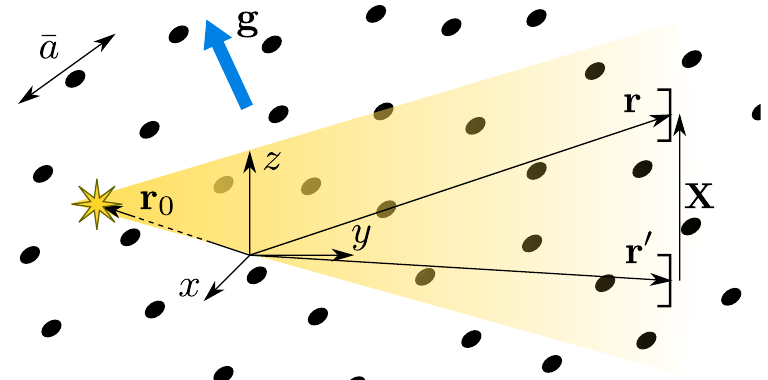
Figure 1. Schematic representation of the light propagation from a source at a point r 0 inside an infinite magnetic nanocomposite medium with a gyration g containing scatterers with an anisotropy axis ¯ a . Electromagnetic field detectors are placed at points r and r (cid:48) , X ≡ r − r (cid:48)